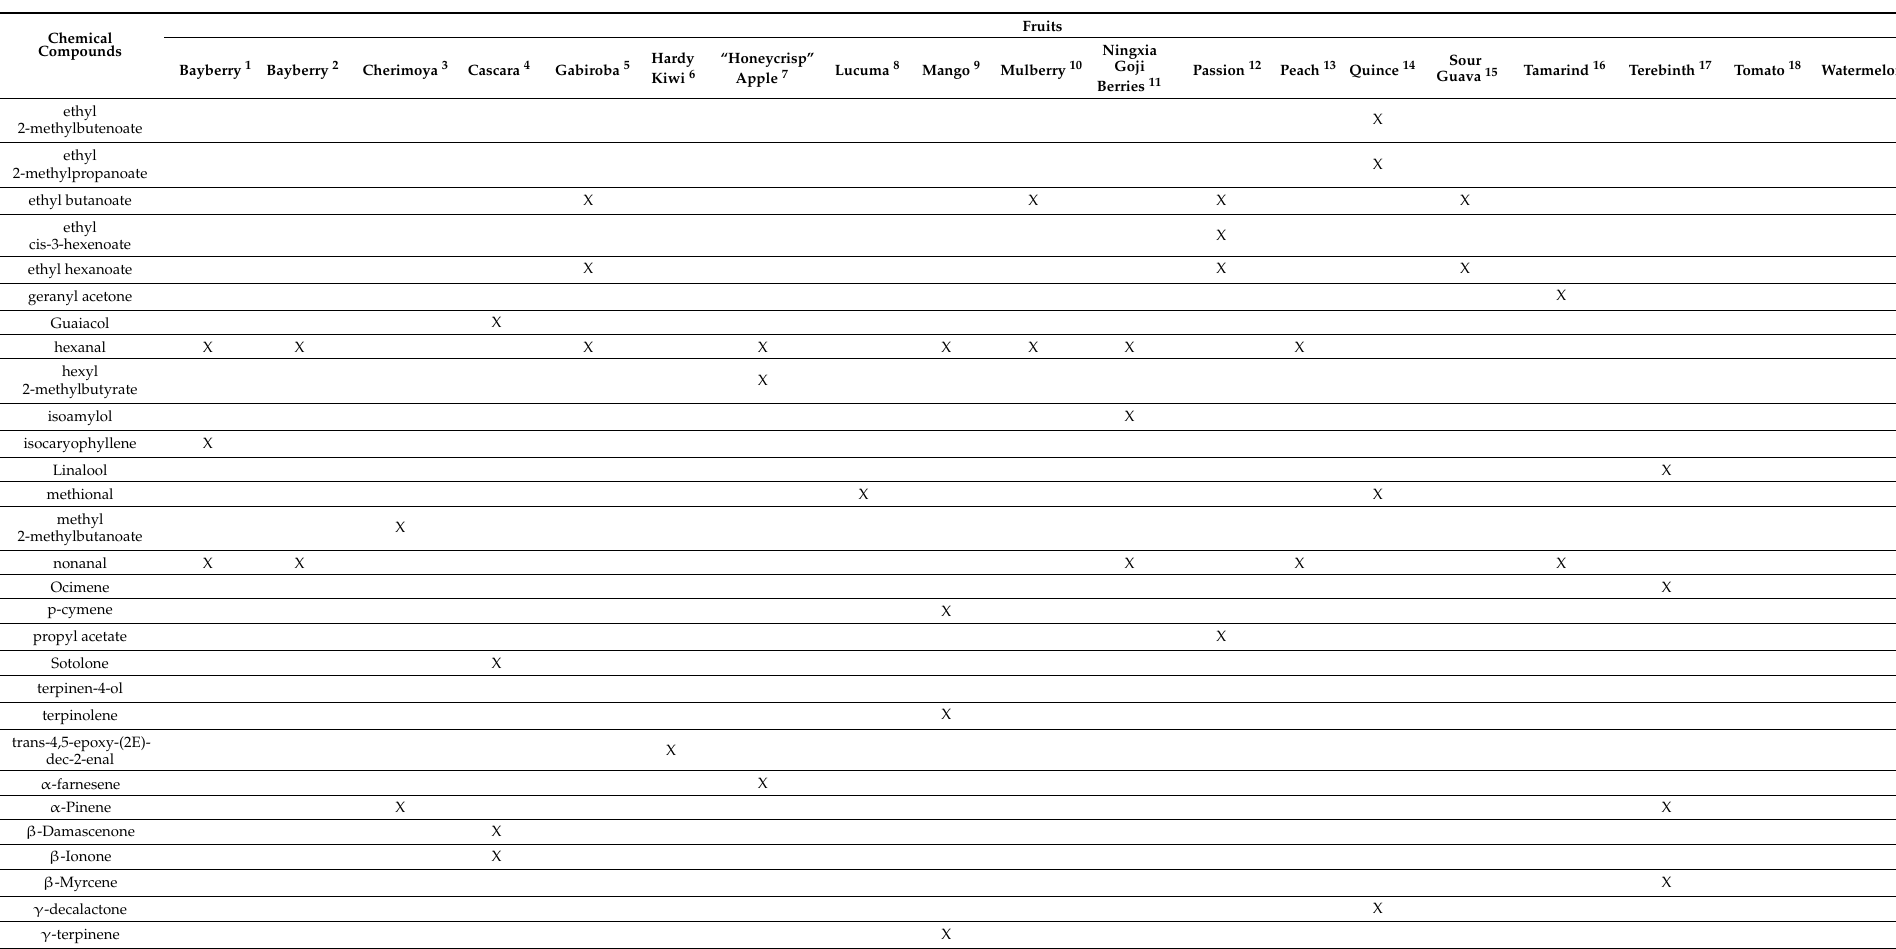
Table 3. The five most important chemical compounds found using gas chromatography–olfactometry of fruit aroma (per column) related by the literature (2015–2021). Chemical Compounds